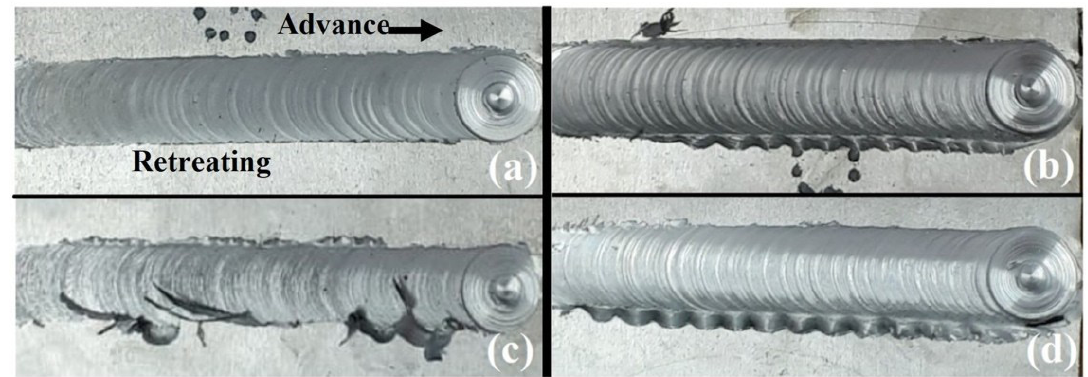
Figure 4. Visual appearance of the welds obtained by FSW: (a) welded joint 1, (b) welded joint 2, (c) welded joint 3, and (d) welded joint 4.